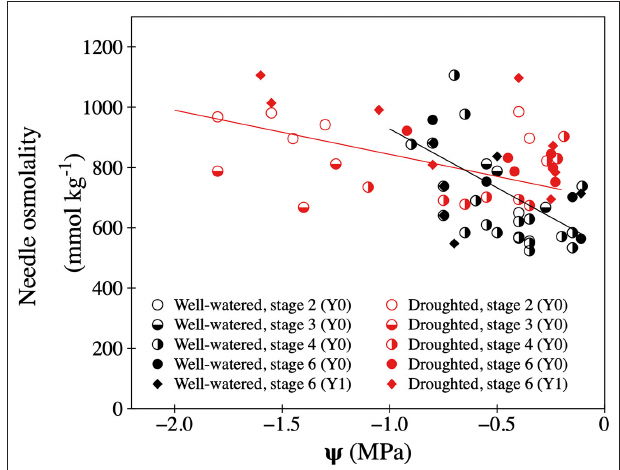
FIGURE 2 | Relationship between shoot water potential ( 9 ) and needle sap osmolality in needles of well-watered (black symbols) and droughted (red symbols) P. mariana trees. Individual observations from current year (Y0) shoots in different development stages: Stage 2 (open circles), stage 3 (half-filled circles), stage 4 (left side filled circles), and stage 6 (filled circles). Values for 1-year old (Y1) shoots are showed as filled diamonds. Significant relationships between Ψ (x) and needle sap osmolality (y) for developing shoots on well-watered trees (black line, y = 537.4–390.7x, R 2 = 0.356, p < 0.001) and droughted trees (red line, y = 697.2–146.6x, R 2 = 0.256, p < 0.001).